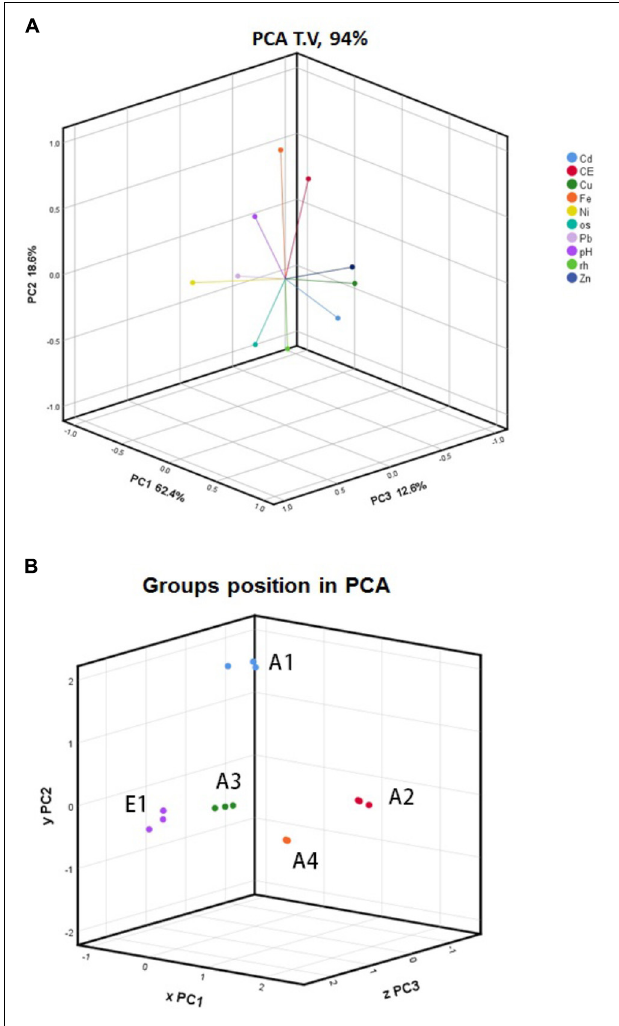
FIGURE 3 | Principal component analysis (PCA) of (A) physicochemical parameters of chars and (B) char data sets. All data gathered from all biological replicates of five chars, A1, A2, A3, A4, and E1, were analyzed using PCA. The legend indicates the color codes of the different parameters: CE, electrical conductivity; os, organic matter; rh, moisture